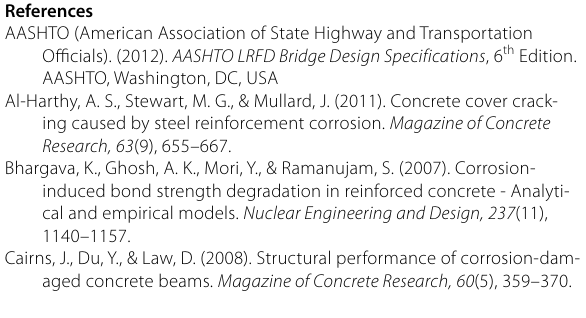
Case-1D, Case-2D, Case-3D: longitudinal reinforcement ratio & transverse reinforcement ratio—64% of Case-1, Case-2, Case-3.